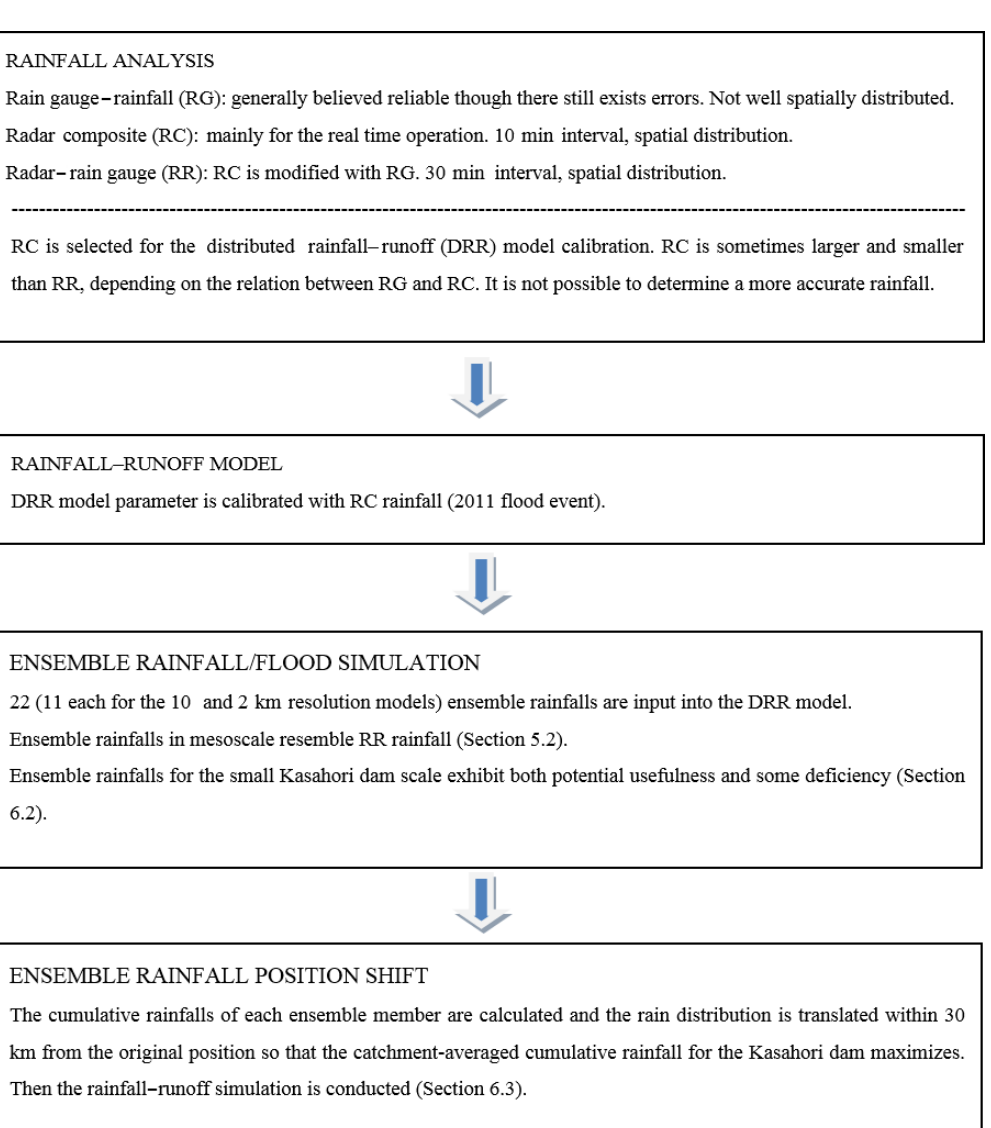
Figure 11. Flowchart of the overall procedure for the ensemble weather/flood